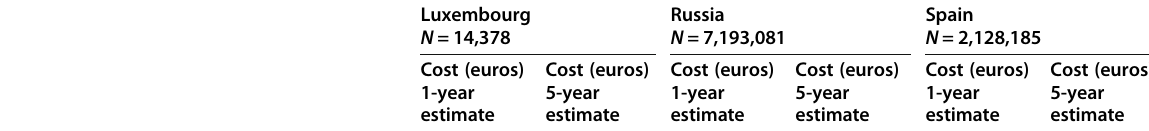
Table 8 MOH costs (population